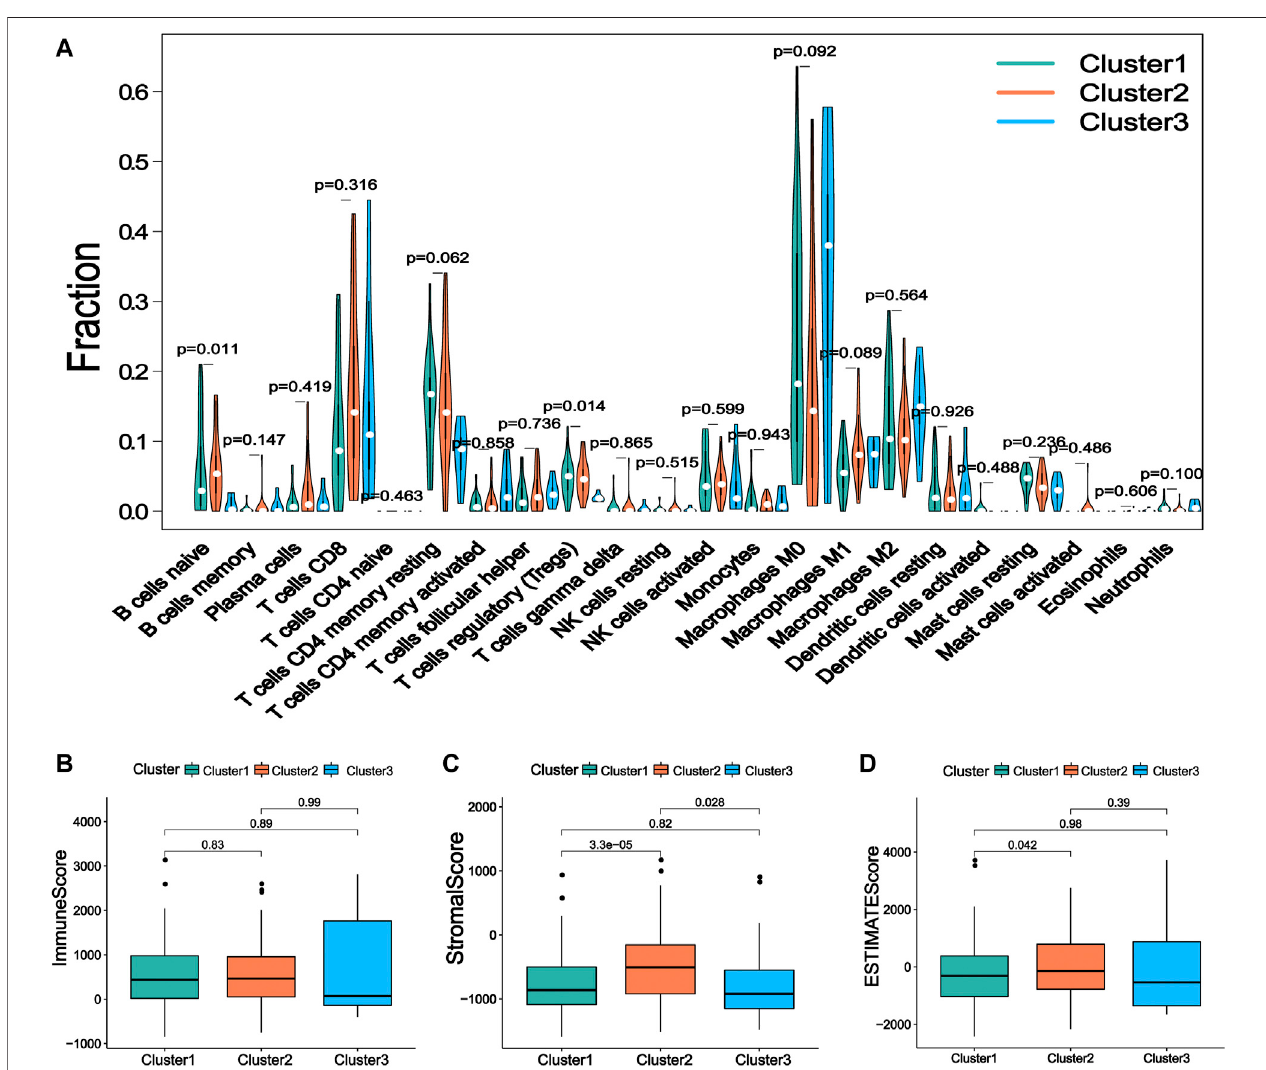
FIGURE 3 | The immune characteristics of the prognostic lncRNA patterns associated with three m6A regulators. (A) The difference of 22 kinds of immune cell in fi ltration levels under the three kinds of prognosis m6A regulator-related lncRNA. (B) The expression of immune score, (C) stromal cell score, and (D) comprehensive score in lncRNA patterns of three kinds of prognosis m6A regulator-related